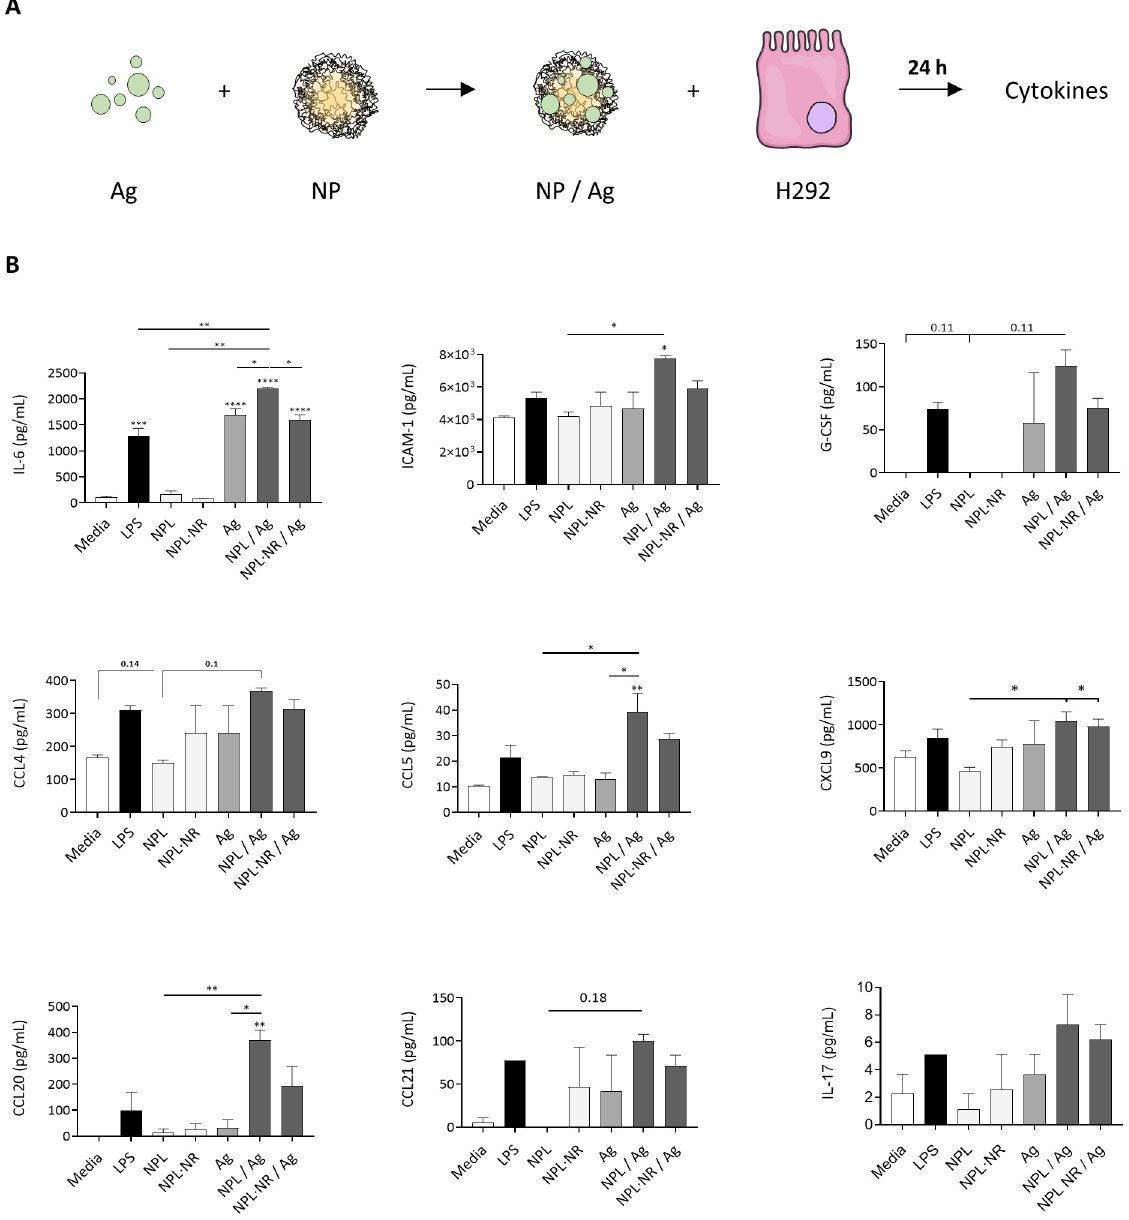
Fig 7. The immunogenicity of NPs and Ag was evaluated on H292. The cells were incubated for 24h with LPS (1 μ g/mL), empty NPs (i.e without Ag, 15 μ g/mL), Ag (5 μ g/mL) alone or Ag loaded into NPs (30% weight ratio), and the cytokine and chemokine secretions were measured by Multiplex assay. Results represent mean ± SEM of at least 3 independent experiments, and statistical comparisons were made by one-way ANOVA. � p < 0.05, �� p < 0.01, ��� p < 0.001 ���� p < 0.0001.